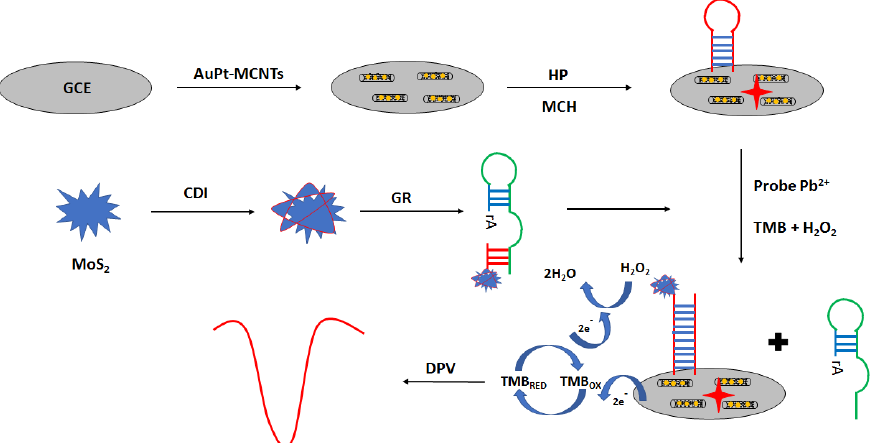
Figure 23. The sensing principle scheme of the electrochemical aptasensor towards lead ions with the application of peroxidase-like GR sequence aptamer—functionalized 3D—flower MoS 2 microsphere hybrid as signaling probes.